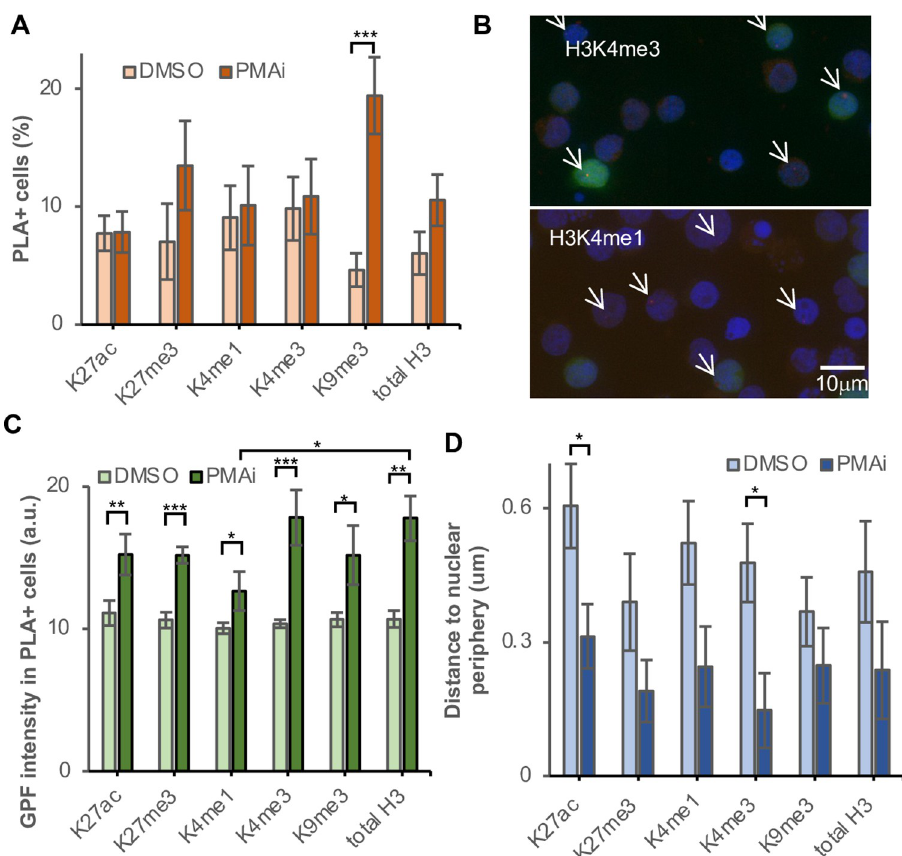
Fig 5. Non-permissive chromatin marks increase in the surviving population after T cell stimulation. (A) H3 modifications found at the HIV-1 promoter at 16 h post T cell stimulation. (B) GFP expression in cells with HIV-1 associated with different marks. (C) Quantification of GFP. (D) Distance to nuclear periphery of the HIV-1 locus. P- values � p < 0.05, �� p < 0.01, ��� p <